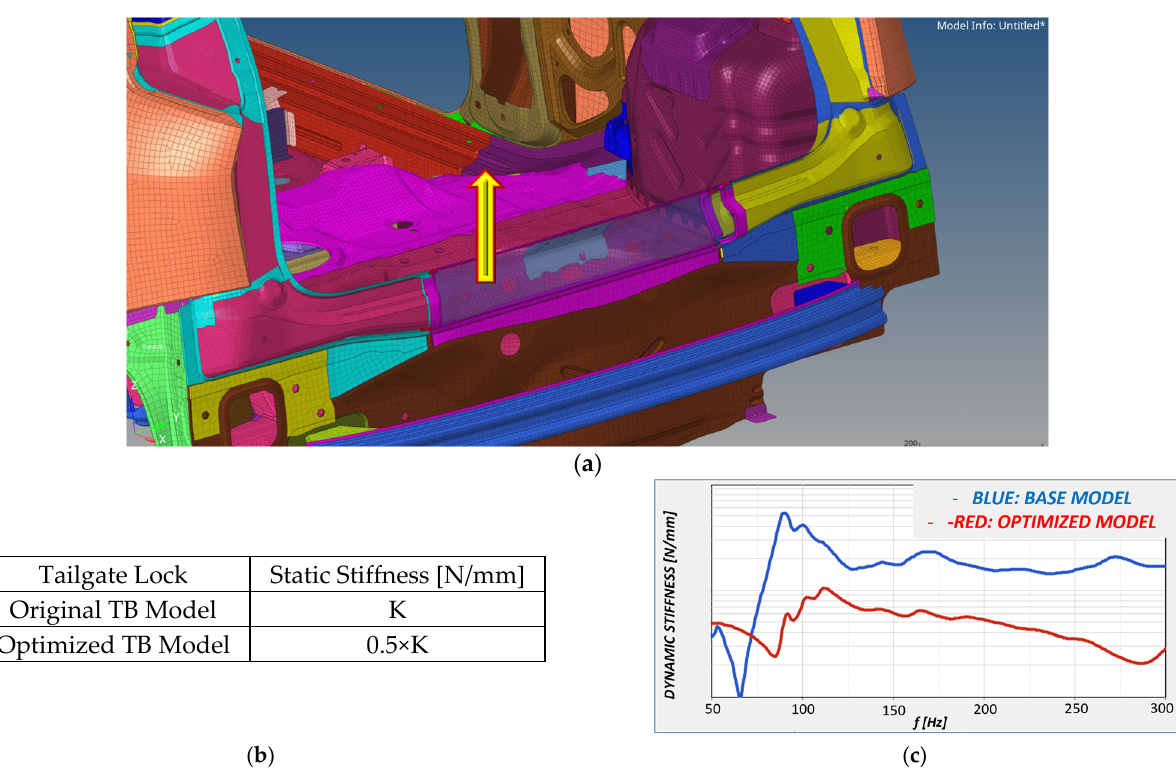
Figure 23. Force application point ( a ), static ( b ), and dynamic ( c ) stiffness of the tailgate lock. As can be seen from the values obtained, with the exception of the static stiffness of the hinge attachment, there was a general decrease in both static and dynamic stiffness. A 50% decrease in the static stiffness was recorded for the tailgate lock with respect to the original model (Figure 23b). The dynamic stiffness of the tailgate lock for the optimized model was, at all frequencies, lower than the dynamic stiffness of the original model (Figure 23c). In order to recover the original stiffness, some modifications were made to the model: the thickness in the critical areas was increased from 2 mm to 4 mm, as shown in Figures 24 and 25 (highlighted in red, the areas undergoing such modifications). Moreover, some modifications were made to reinforce the lock attachment, which was even more critical than the hinge attachment area: further connections, highlighted by red circles (Figure 26), were added between the internal and external parts.